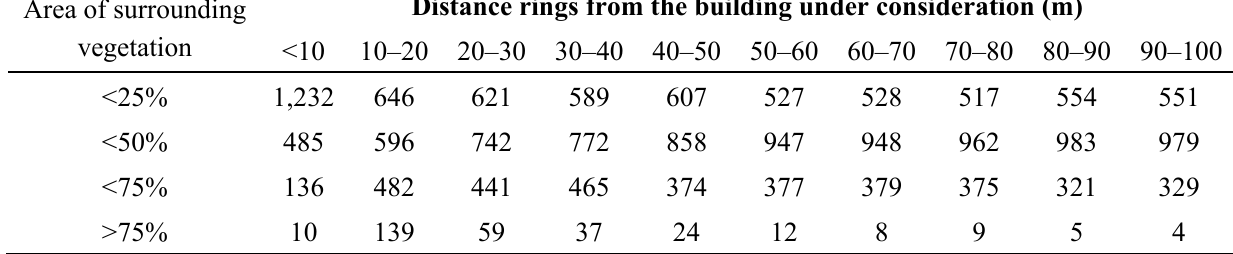
Table 1: The number of buildings analyzed according to the fractions of surrounding vegetation. Subsequent calculations allow for a more “human-centric” expression of greenness in the vicinity of residences